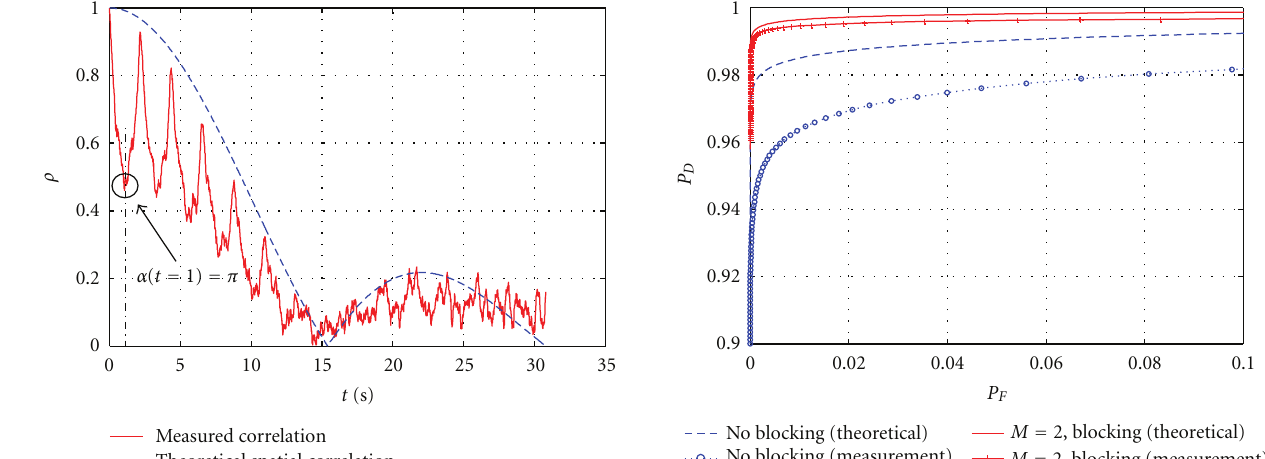
connected to an RF front-end for downconversion, sam- pling and despreading. A static reference antenna, located